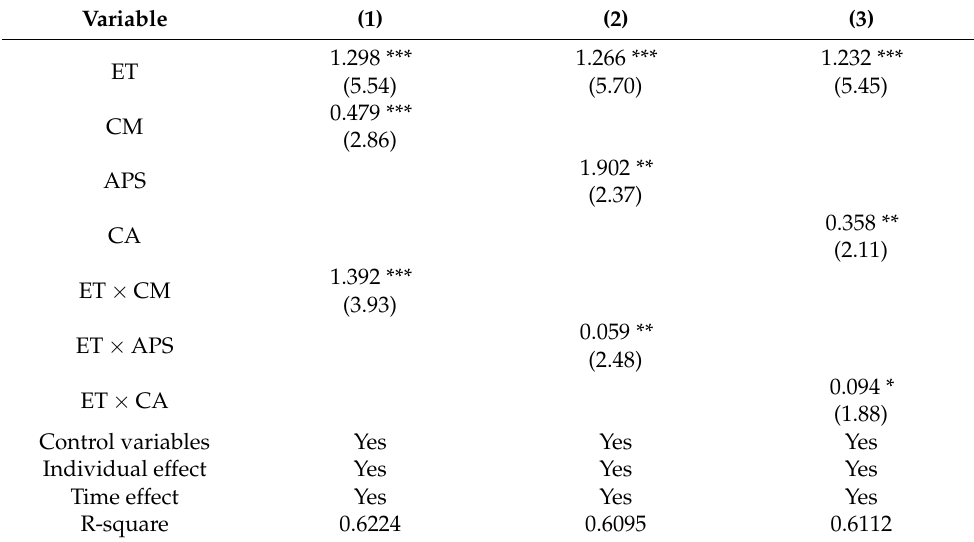
Table 5. The results of the mechanism